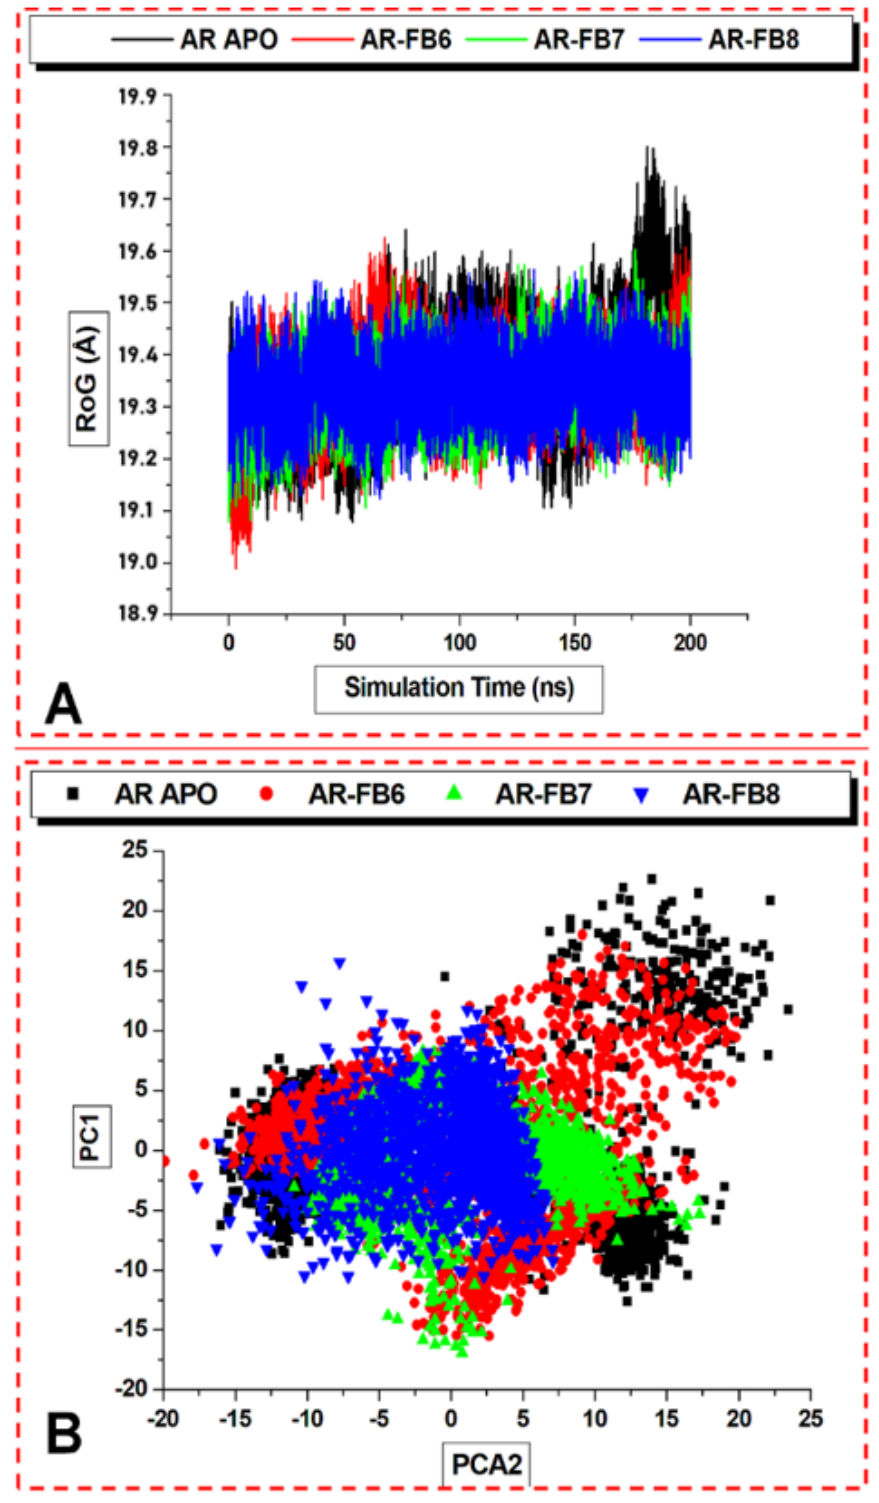
Figure 8. The radius of gyration, RoG ( A ), and the principal component analysis, PCA ( B ), illustrate the compactness and displaced inter-atoms of the ALR2 protein, respectively.